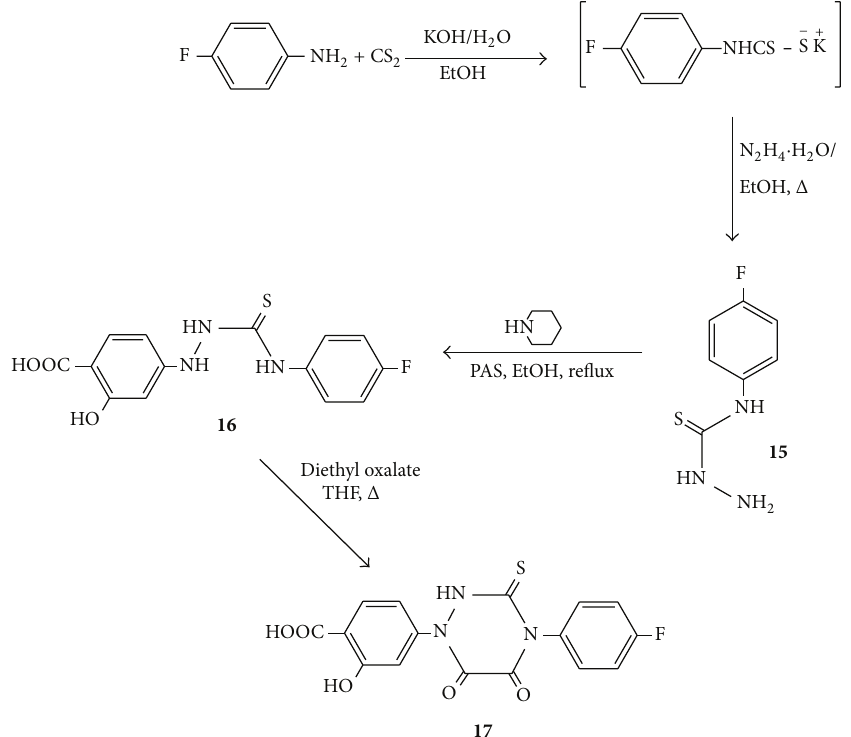
Scheme 3: Synthesis of p -amino salicylic acid derivatives 16-17